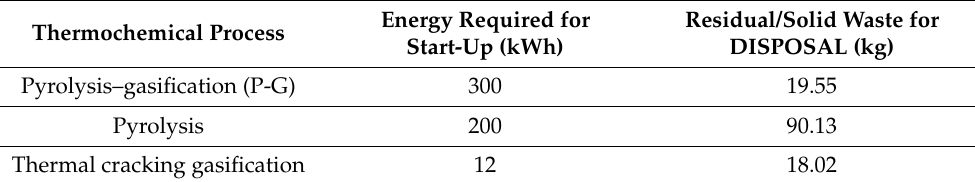
Table 7. Estimated Energy consumption per kWh based economic analysis